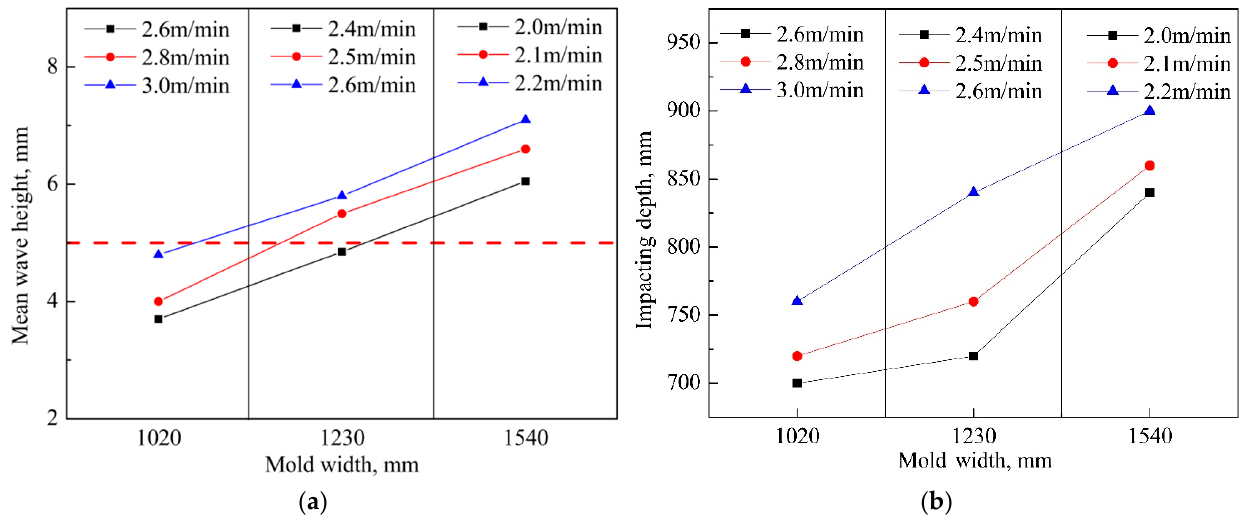
Figure 4. ( a ) Mean wave height and ( b ) impacting depth of three mold widths with 3P-0 SEN while the SEN submergence depth was 120